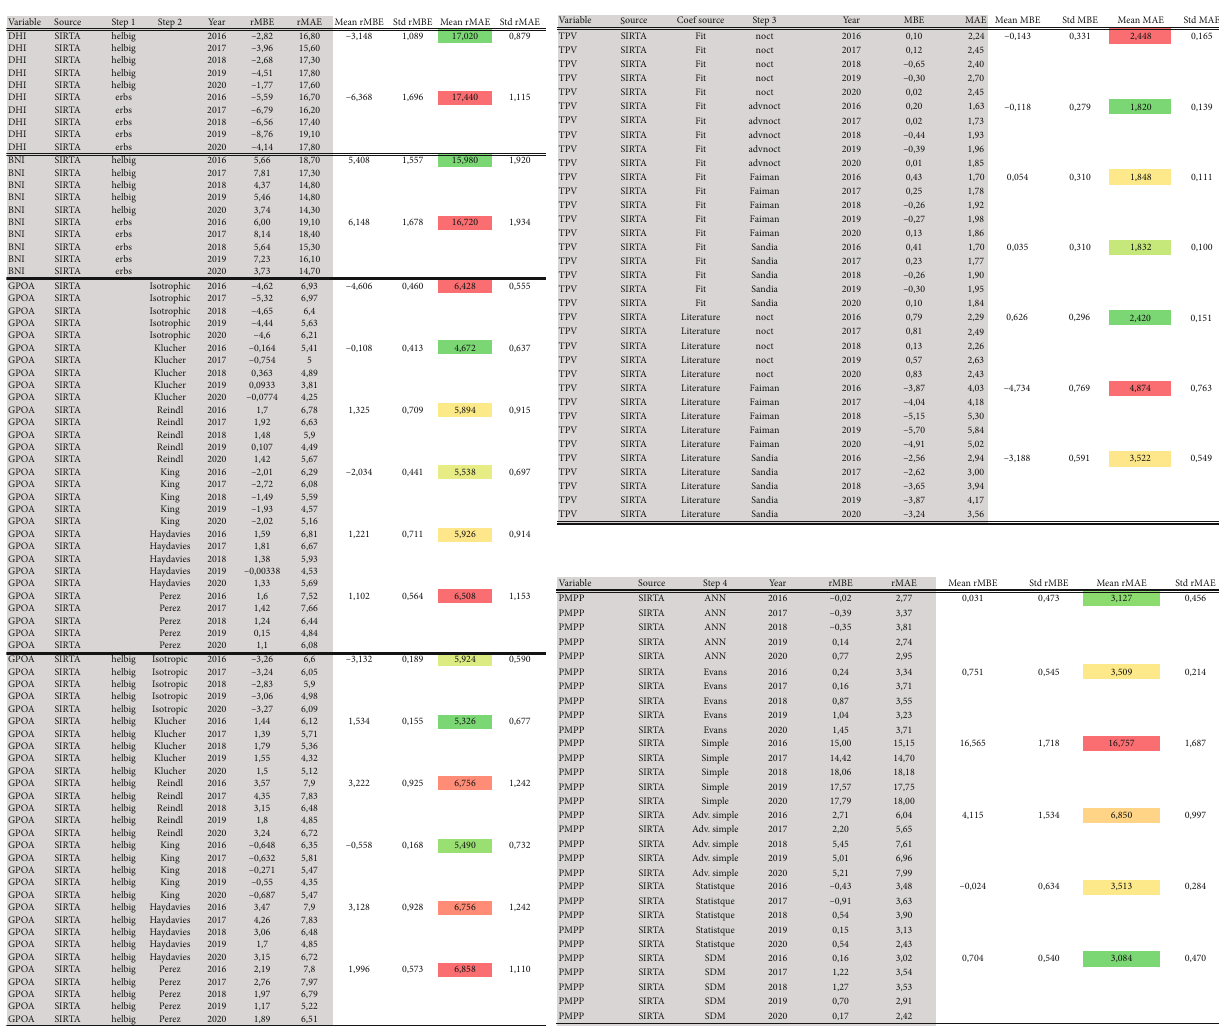
Figure 9: Computed rMBE and rMAE for SIRTA in situ ground-based measurements, for each modeling step. Colors are performance indicators (from green for the best to red for the (2) Step 2 ⟶ from GHI, DHI, and BNI to G POA : 6 models models in 2 con fi gurations